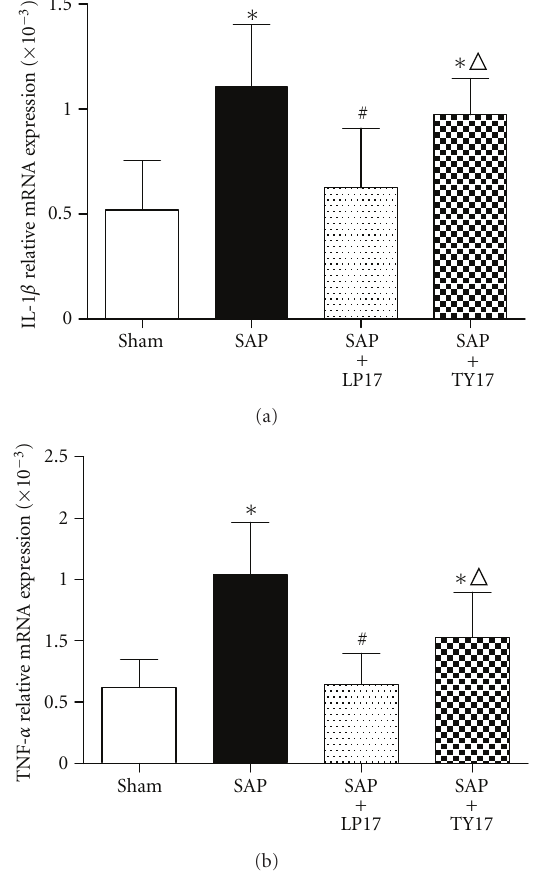
Figure 2: The expression of TREM-1 in the intestinal and pancre- atic tissues.